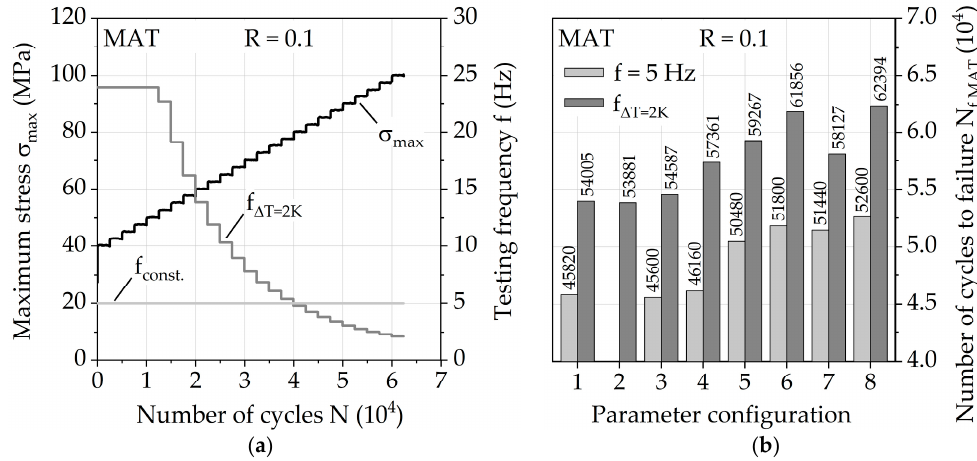
Figure 8. ( a ) Multiple amplitude test parameters visualized with constant testing frequency and adjusted frequency for a constant change in temperature Δ T = 2 K; ( b ) according numbers of cycles to failure N f,MAT for all injection molding parameter configurations.